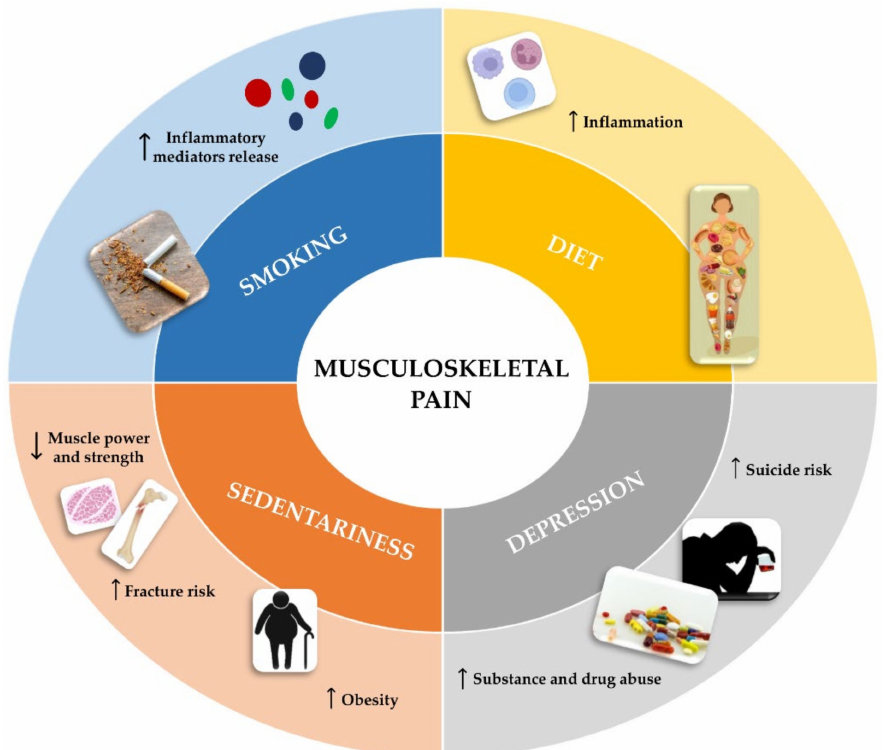
Figure 1. Main risk factors associated with musculoskeletal pain. Some risk factors may promote the musculoskeletal pain onset directly or by influencing lifestyle and work activity. Smoking and a diet high in animal protein and fat are factors that amplify the chronic pain associated with musculoskele- tal disorders by stimulating immune cells to release inflammatory mediators. Depression, which can lead to substance and drug abuse and suicide risk increase, is also associated with musculoskeletal pain onset. Finally, a sedentary lifestyle, correlated with reduced muscle mass and strength, fracture risk increase and obesity, is among the main factors promoting chronic pain